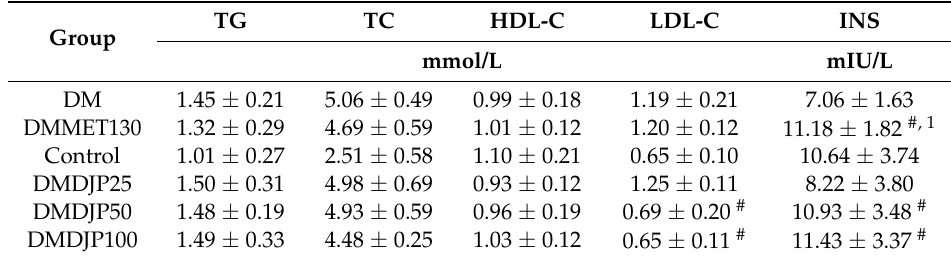
Data are means ± SD; 1 : # = p < 0.05 vs. DM